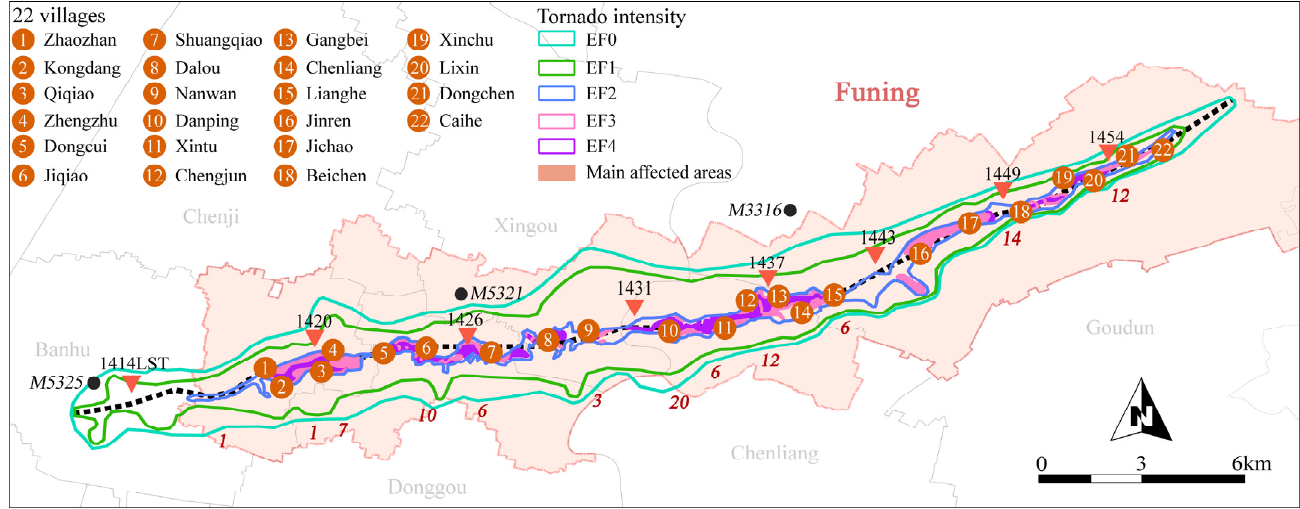
Figure 2. Tornado intensity and location of the 22 affected villages.